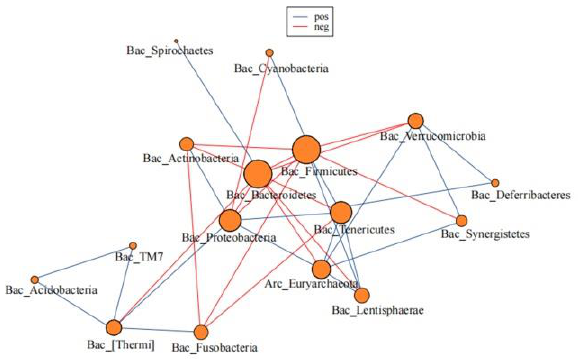
Figure 4. Microbial network of the gut microbiome. The red represents negative associations between two microbiomes, and green represents positive associations between two microbiomes. The number on the line represents the degree of correlation between two microbiomes.